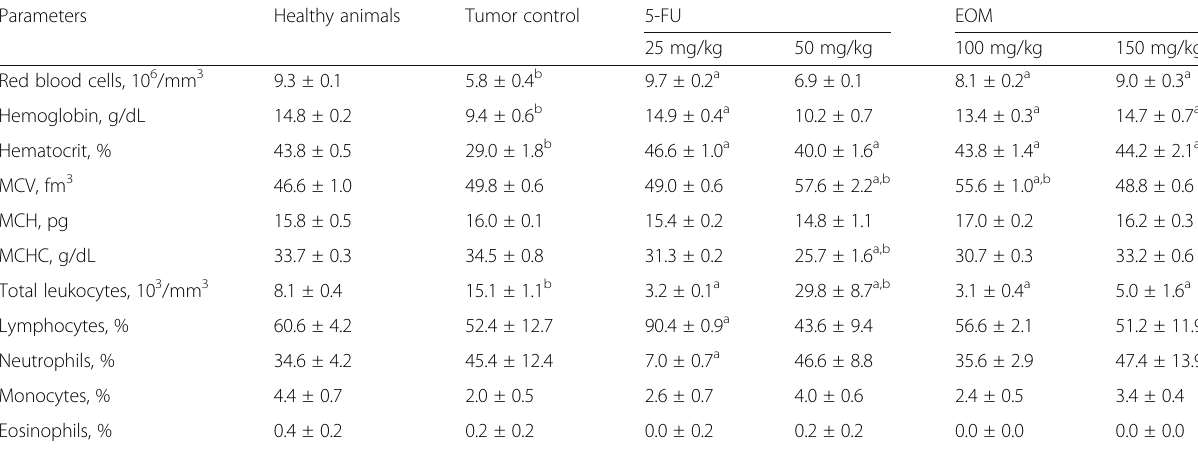
Table 8 Effects of EOM and 5-FU on hematological parameters of peripheral blood of mice ( n =6) subjected to different treatments (9 days)